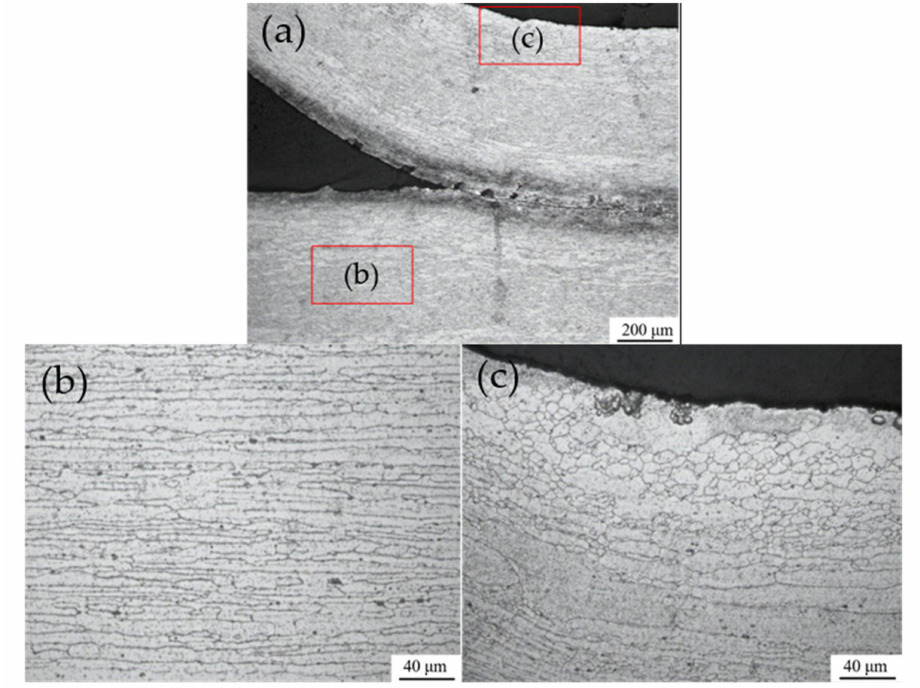
Figure 8. Microstructure of the sample: ( a ) the overall microstructure of the sample, ( b ) the no deforming area, ( c ) the round corner area.